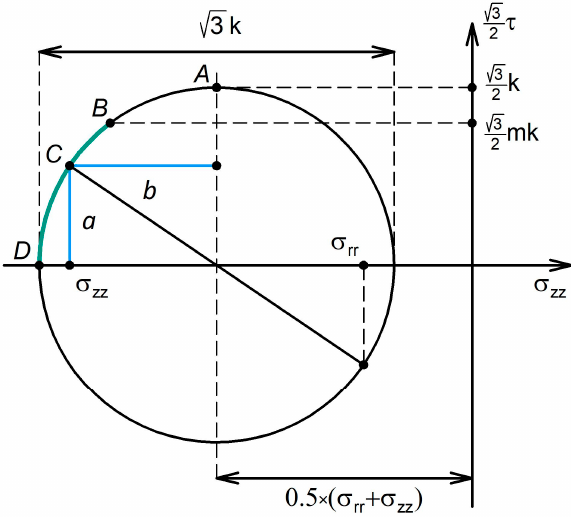
Figure 2. Graphical representation of the gripping condition for an HPT specimen.